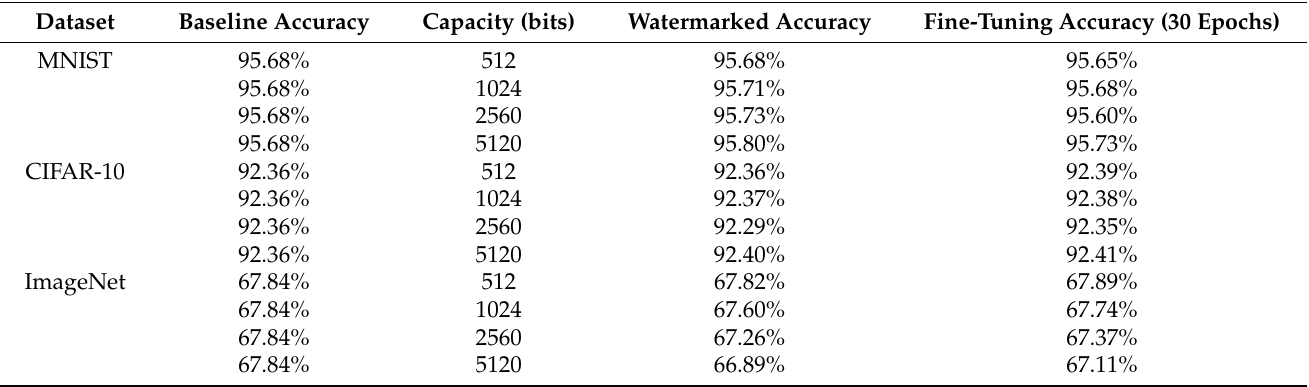
Table 6. The relationship between the capacity of the embedded watermark and model accuracy using MNIST, CIFAR-10, and ImageNet.